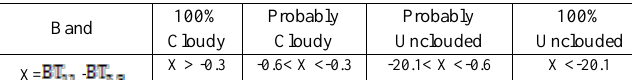
Table 8: Acquired thresholds for